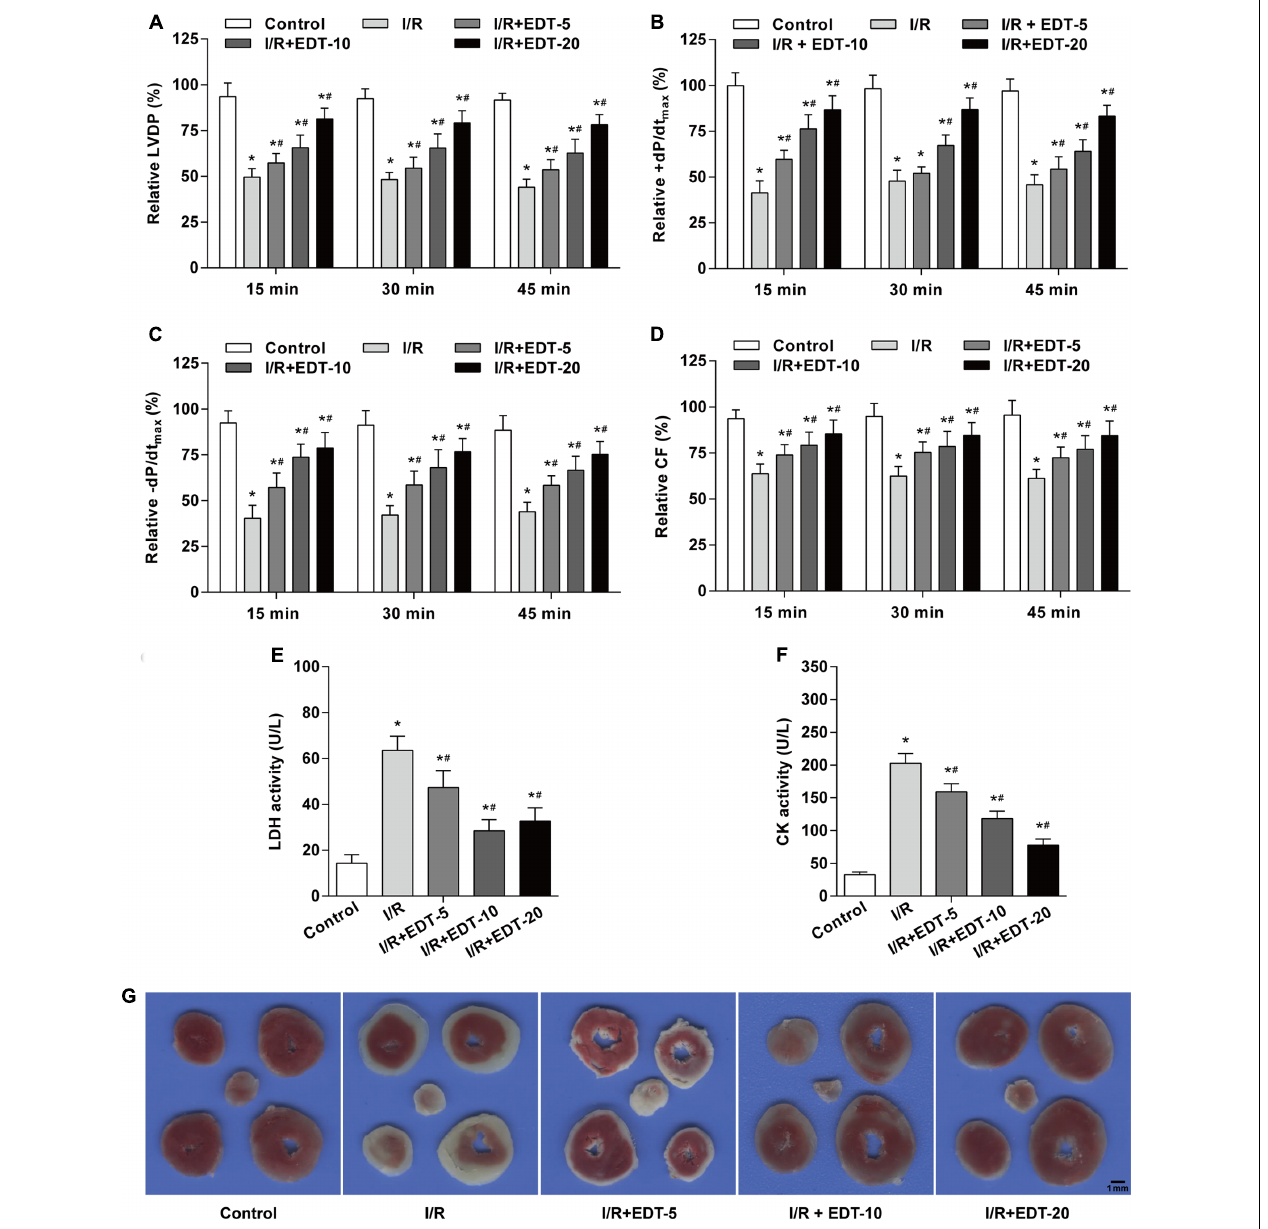
FIGURE 1 | Eriodictyol (EDT) treatment rescues myocardial injury in an ex vivo model of global myocardial I/R. The effect of EDT on LVDP (A) , +dP/dt max (B) , –dP/dt max (C) , and CF (D) in rat hearts were measured using PowerLab data acquisition device. The values of these parameters were normalized to the values of the recorded data before 15 min of zero-flow global ischemia. The levels of LDH (E) and CK (F) in K–H buffer were determined by commercial kits. (G) The infarct size was examined by TTC staining after EDT treatment. Scale bar: 1 mm. n = 8 for each group. All data are the mean ± SD. ∗ P < 0.05 compared with control group, # P < 0.05 compared with I/R